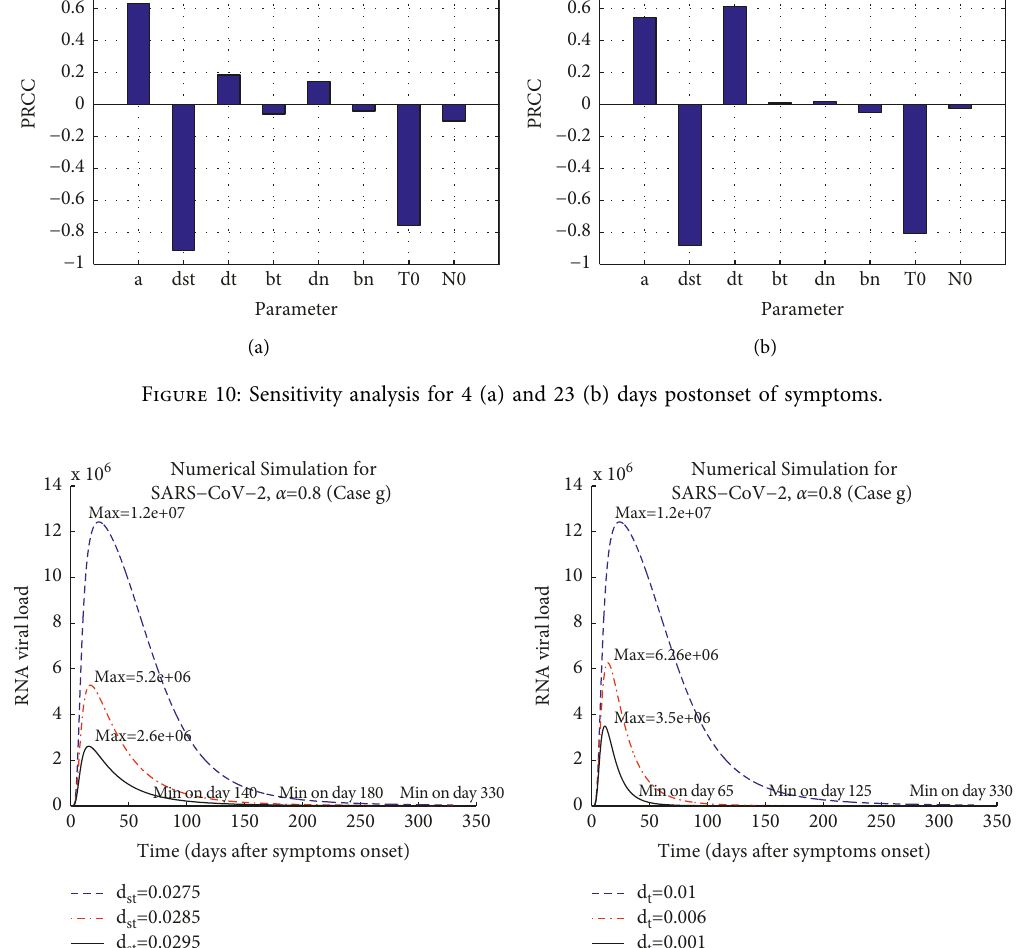
d st (a) and t (b) parameters for long COVID case g